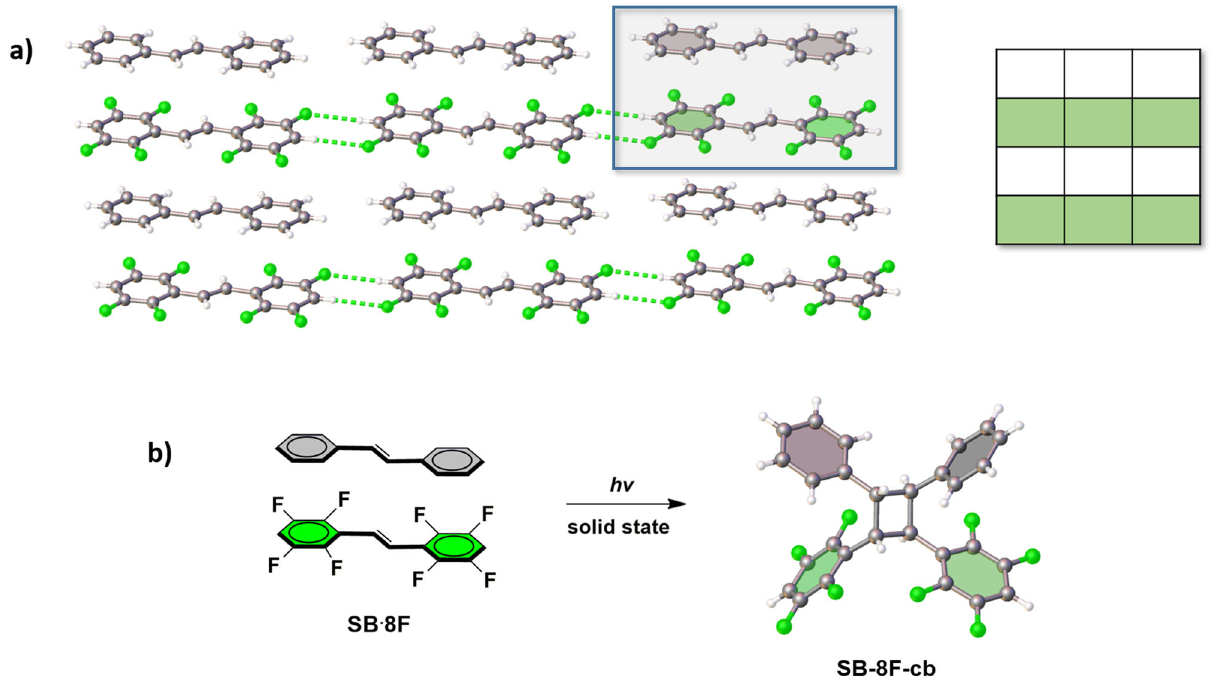
Fig. 4 Cross-photoreaction showing X-ray structures. a SB ˑ 8F (inset: representation of packing type). b SB-8F-cb with solid-state photoreaction highlighted.